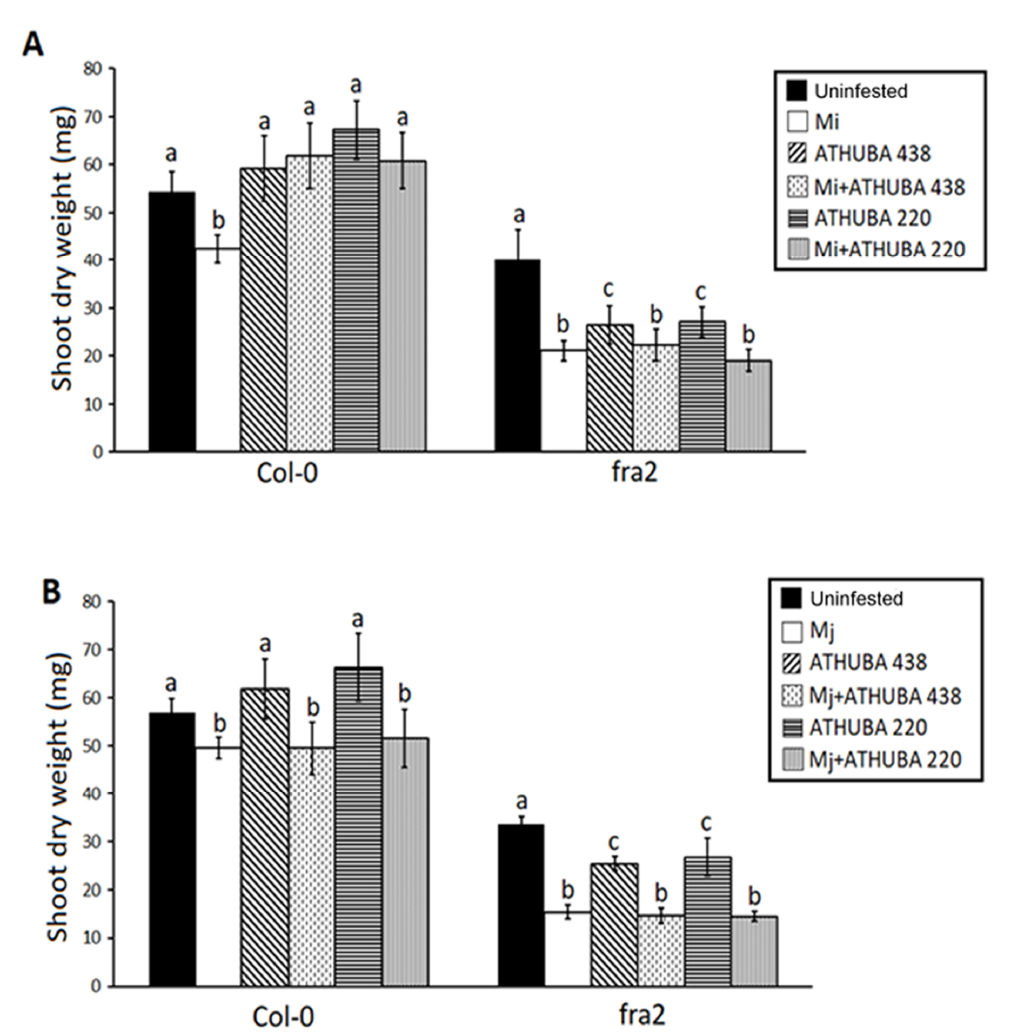
Figure 4. Arabidopsis thaliana L. plant (Col-0) and fra2 katanin mutants shoot dry weight (mg), of control (uninfested), infested with either M. incognita ( A ) or M. javanica (Mj) ( B ) or treated with Streptomyces monomycini ATHUBA 220 and Streptomyces colombiensis ATHUBA 438 spore suspensions at 10 7 cells / g of soil (prior Mi / Mj infection or not). 45 days after application of the depicted treatments / infections. Di ff erent letters above columns correspond to statistically significant di ff erences between treatments (one-way ANOVA, Tukey’s test at p < 0.05; for all cases n =